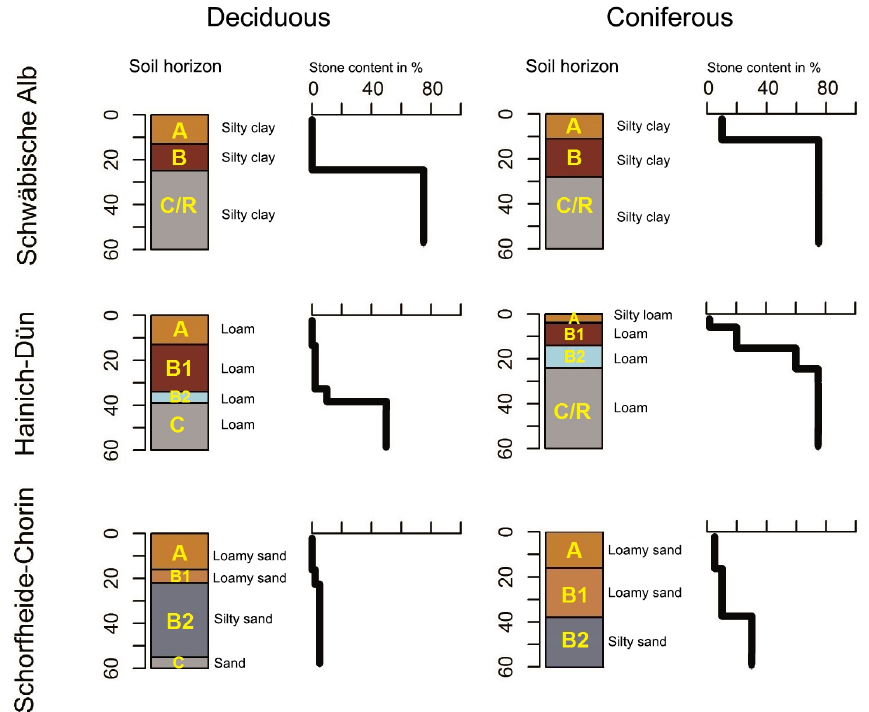
Figure 2. Soil horizons, texture and rock fractions of the six experimental plots. Soil type classification according to the World Reference Base for soil (FAO,